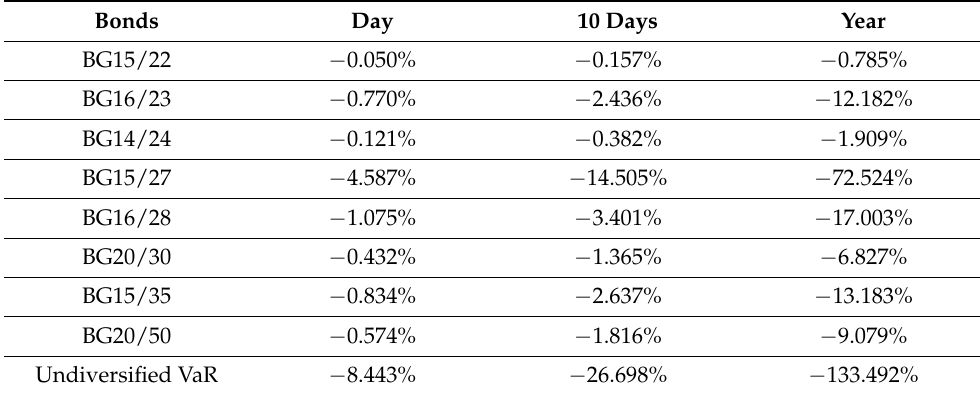
Table 4. The Value at risk for Bulgarian’s Sovereign